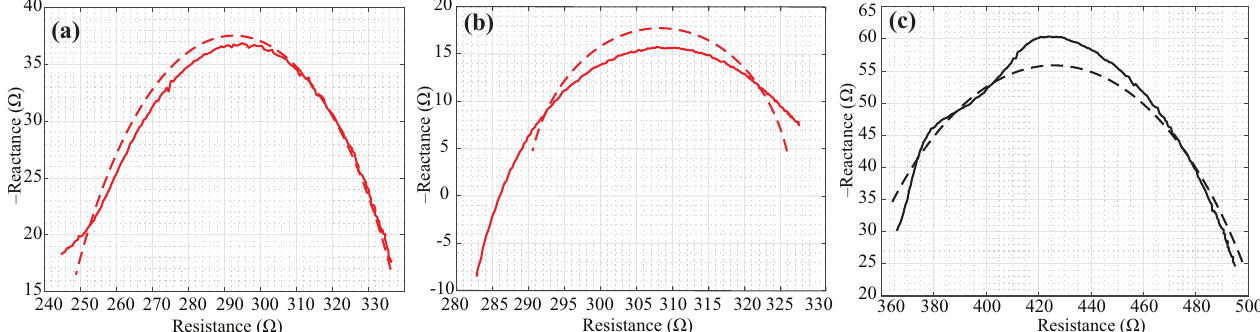
Figure 3. Samples of participant data excluded (solid) from statistical analysis due to ( a ) high-frequency hook artifact, ( b ) positive high-frequency reactance, and ( c ) motion artifacts. Simulations using identified Cole-impedance parameters (dashed) shown to highlight poor fitting for datasets with these characteristics.